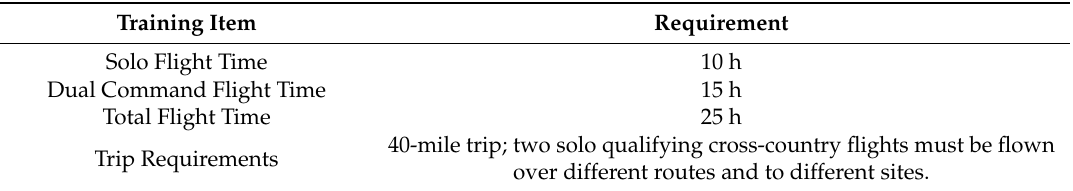
Table A4. Practical training requirements for British ultralight